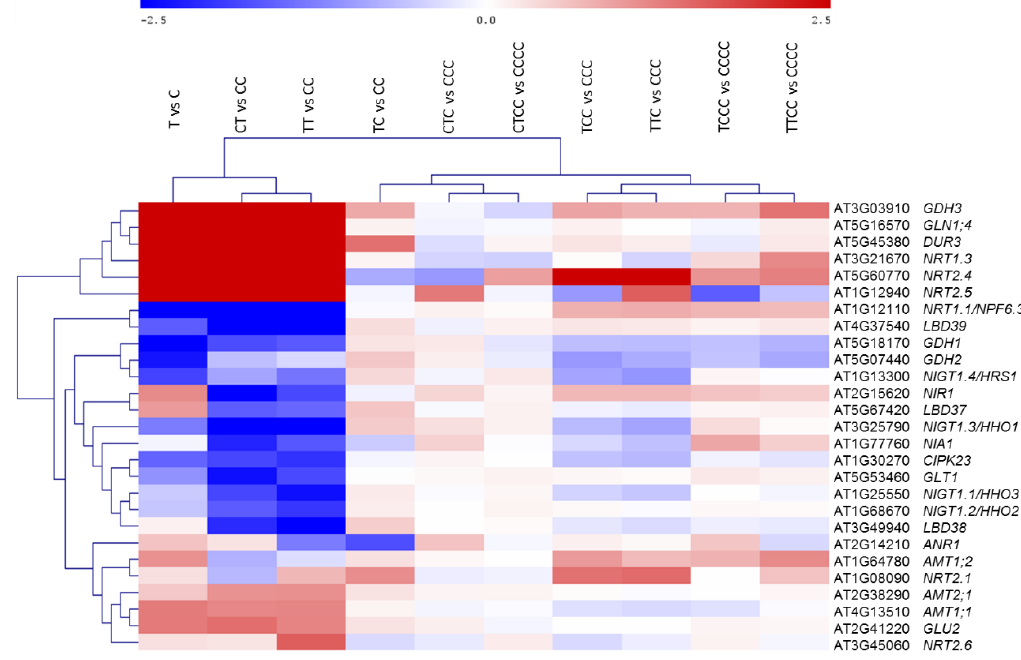
Figure 6. Gene expression analyses of some genes related to N response by real-time RT-PCR experiments. The color scale red-blue refers to Log 2 FC values of differentially modulated transcripts, red refers to upregulated transcripts, blue refers to downregulated ones ( N = 3). AMTs , ammonium transporters; ANR , MADS box transcription factor; CIPK , CBL-interacting protein; DUR3 , urea transporter; GDH , glutamate dehydrogenase; GLN , glutamine synthetase; GLT1 , NADH-dependent glutamate synthase 1; GLU2 , ferredoxin-dependent glutamate synthase 2; LBD , LOB domain-containing protein; NIA , nitrate reductase; NIGTs , nitrate-inducible GARP-type transcriptional repressors; NRTs , nitrate transporters.